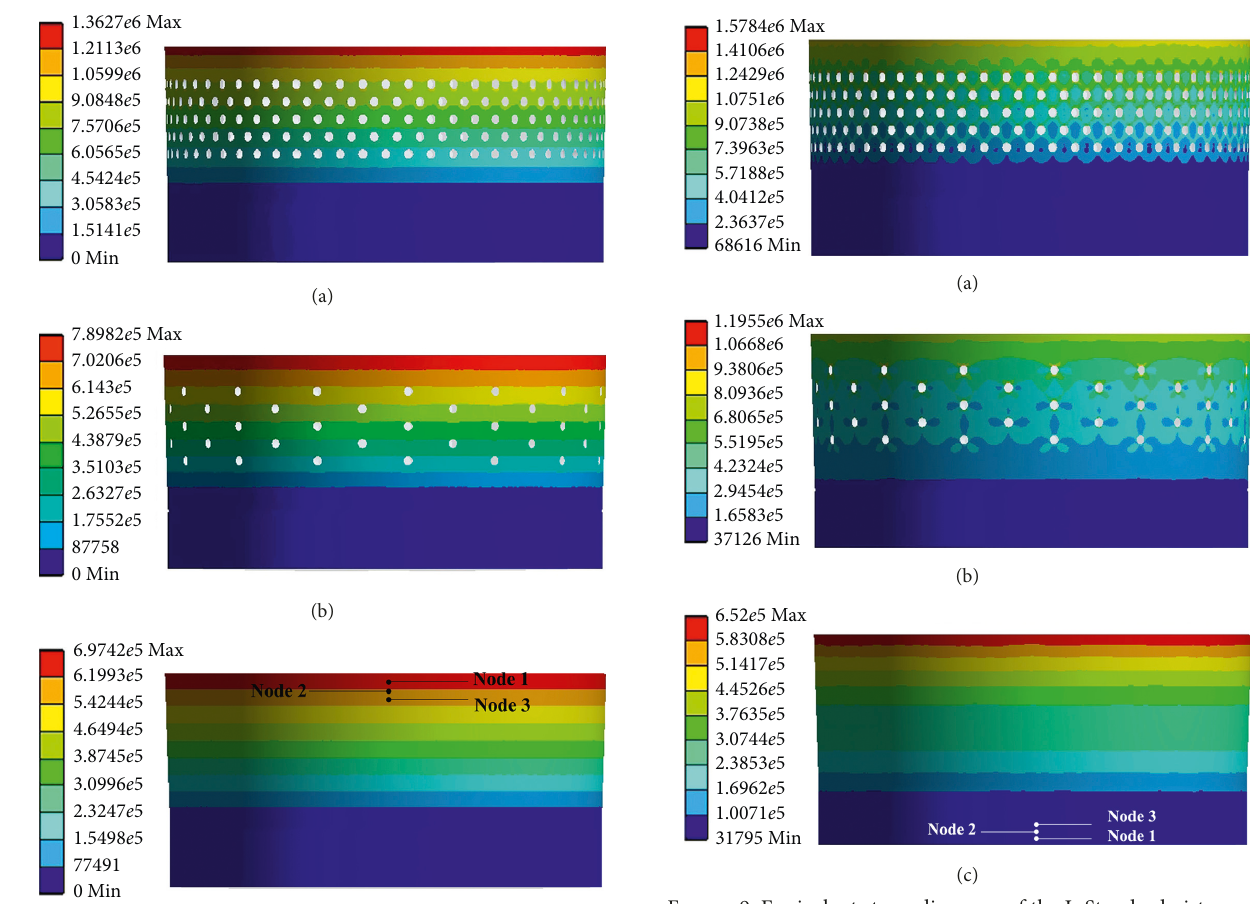
Figure 9: Equivalent stress diagrams of the L-Standard piston and dimpled pistons: (a) L-S1 piston, (b) L-D1 piston, and (c) L- Standard piston. Figure 8: Contact pressure diagrams of the L-Standard piston and